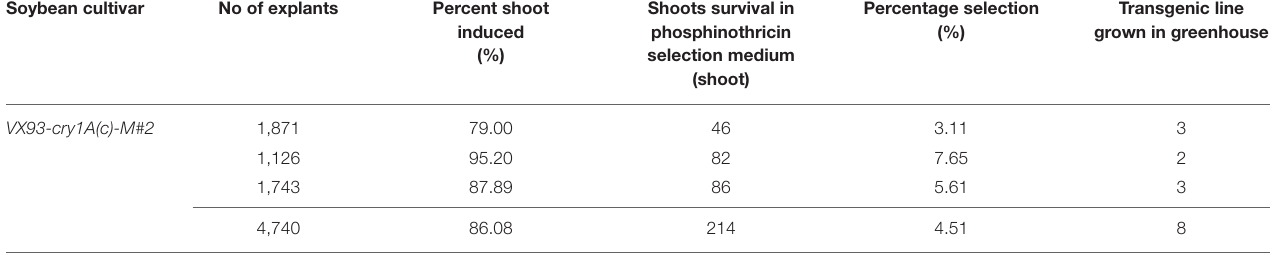
TABLE 1 | The transformation efficiency of cry1Ac -M#2-mediated Agrobacterium tumefaciens transferred to VX93 soybean cultivar. Soybean cultivar